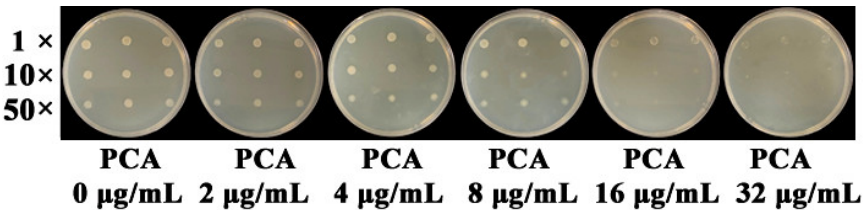
Figure 4. Inhibition of PCA against A. citrulli on LB plates. The one-, ten-, and fifty-fold dilutions (1 × , 10 × , and 50 × ) of the bacterial suspension were spotted onto LB plates, which contained different concentrations of PCA at 0, 2, 4, 8, 16, and 32 μg/mL. Inoculated plates were incubated at 28 °C for 72 h. Each treatment was replicated three times, and each experiment was repeated thrice inde-